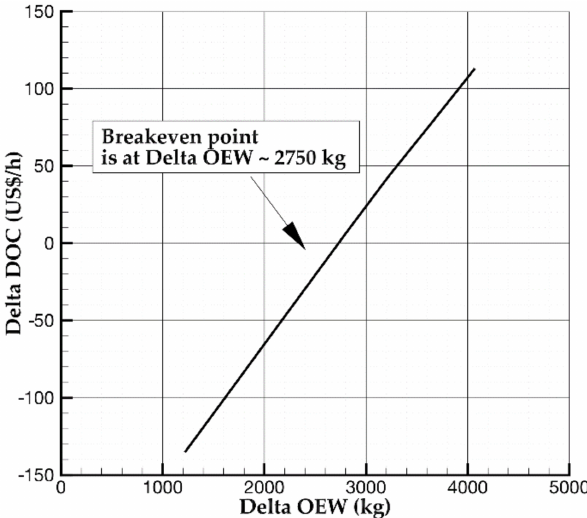
Figure 8. Breakeven point for the reference aircraft: Delta DOC vs. Delta OEW due to